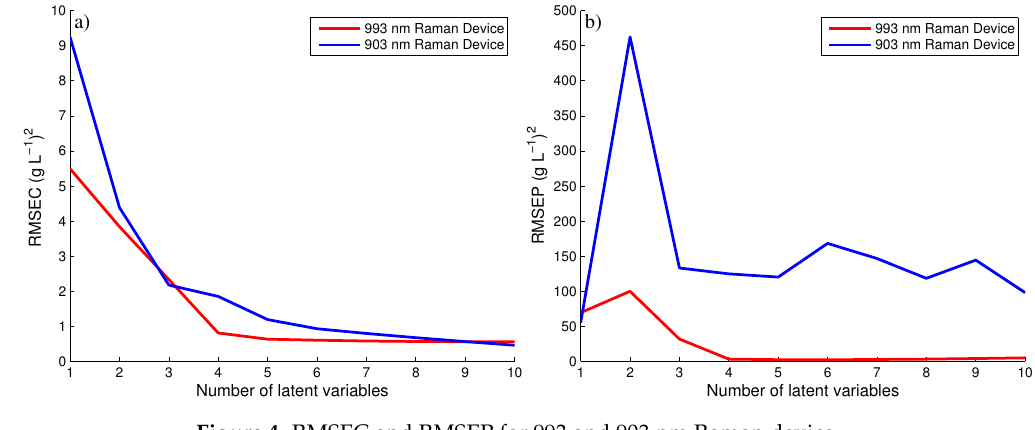
Figure 4. RMSEC and RMSEP for 993 and 903 nm Raman